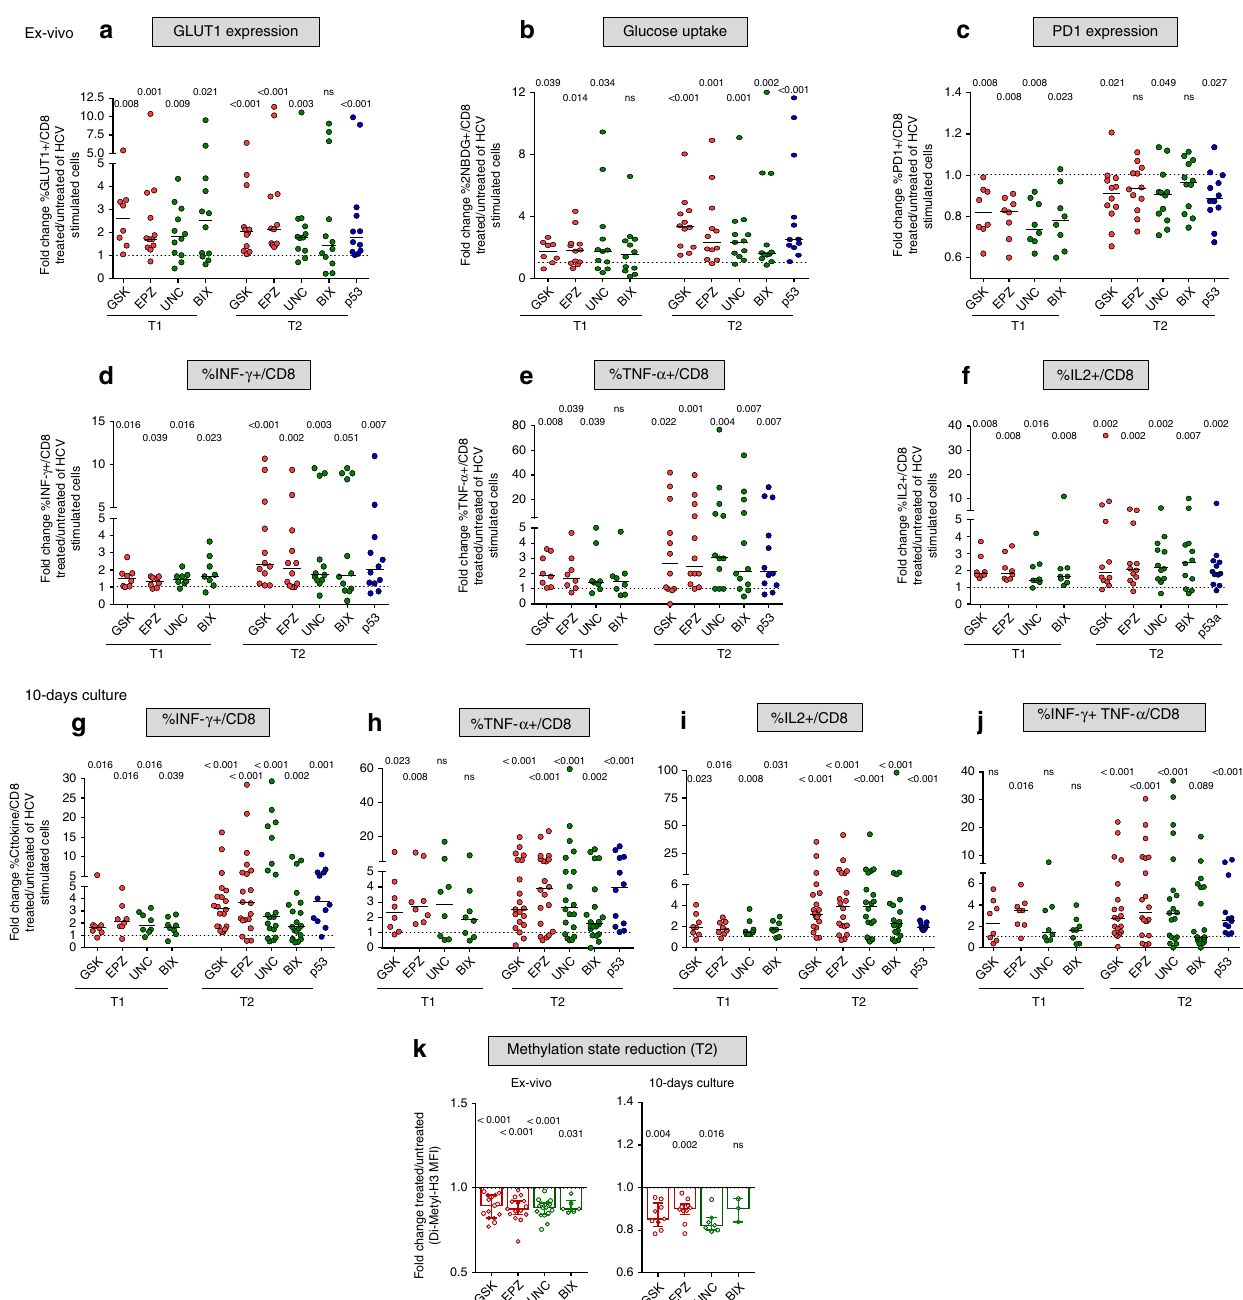
Fig. 7 HMT and p53 inhibitors improve anti-viral and metabolic functions of exhausted HCV-speci fi c CD8 + T cells. PBMC from chronically evolving (T1/early) or chronic (T2/late) HCV patients were stimulated for 40 h with HCV-NS3 peptides in the presence or absence of the EZH2 inhibitors GSK126 (GSK) and EPZ005687 (EPZ) (red dots), of the EHMT2/G9a inhibitors UNC0638 (UNC) and BIX01294 (BIX) (green dots), and of the p53 inhibitor pi fi thrin-alfa (p53) (blue dots). HCV-stimulated CD8 + T cells were then tested in fl ow cytometry for GLUT-1 levels ( a ), glucose uptake ( b ), PD-1 expression ( c ), IFN- γ ( d ), TNF- α ( e ), and IL2 ( f ) production. g – j PBMC from chronically evolving (T1/early) or chronic (T2/late) HCV patients were stimulated for 10 days with HCV-NS3 peptides in the presence or absence of the inhibitors speci fi ed in a and CD8 + T cells were then tested for IFN- γ , TNF- α , IL2, and IFN- γ plus TNF- α production as indicated. Data are presented as the ratio (fold-change) between positive CD8 + T cells detected in treated vs. untreated cultures from individual patients. Statistical analysis was performed with the Wilcoxon signed-rank test; horizontal lines represent median values. k Reduction of the repressive H3K9me2 histone mark was assessed by fl ow cytometry on CD8 + T cells from T2/late chronic HCV patients stimulated for 40 h or 10 days as in a . Data are presented as the ratio (fold-change) between MFI (Median fl uorescence intensity) of H3K9me2 CD8 + T cells detected in treated vs. untreated cultures from individual patients; statistical analysis was performed with the Wilcoxon signed-rank test; columns and dots represent median values and single patients,